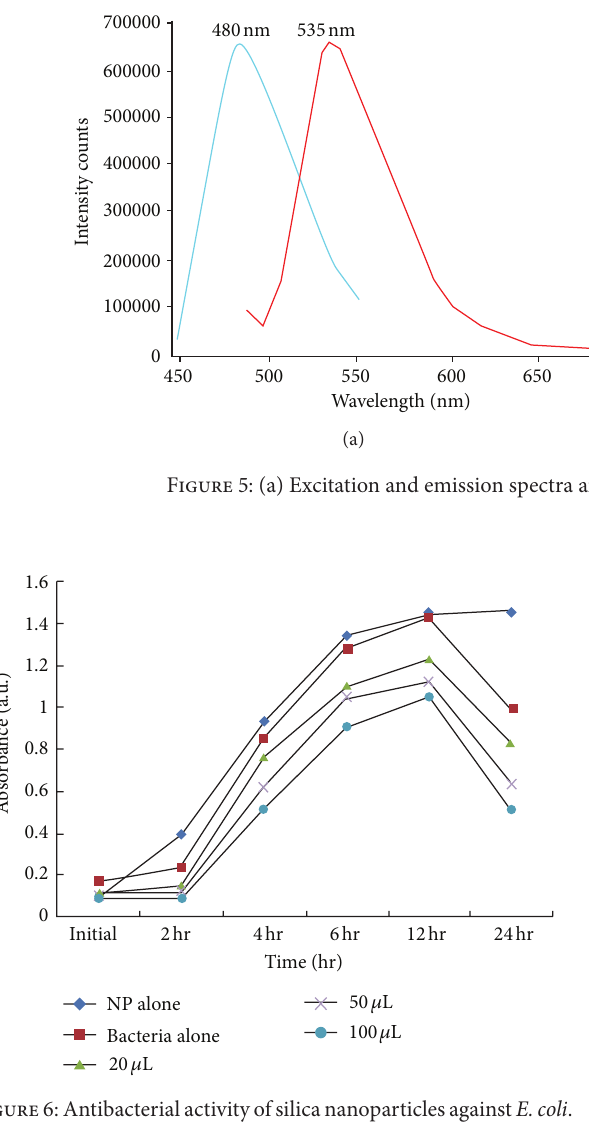
Figure 6: Antibacterial activity of silica nanoparticles against E. coli